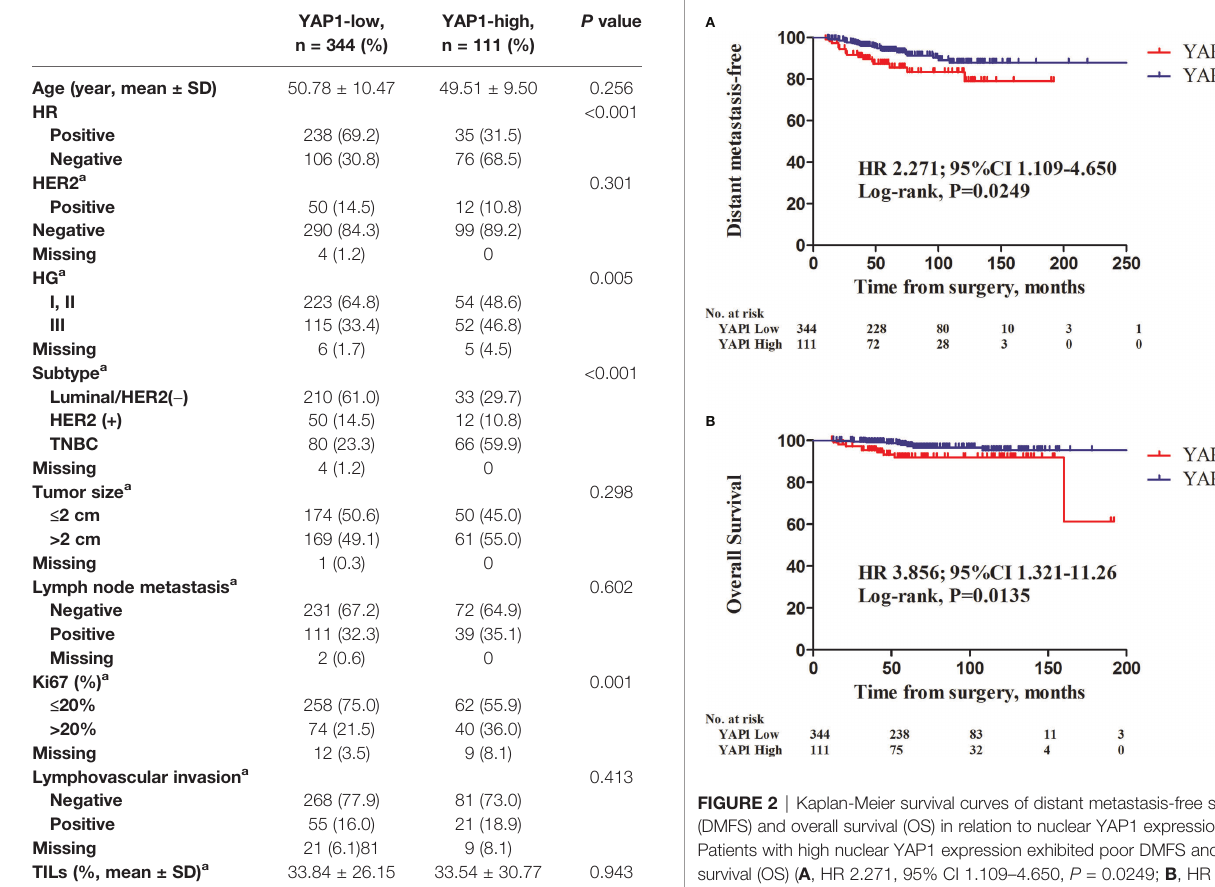
TABLE 1 | Clinical characteristics in relation to nuclear YAP1 expression.